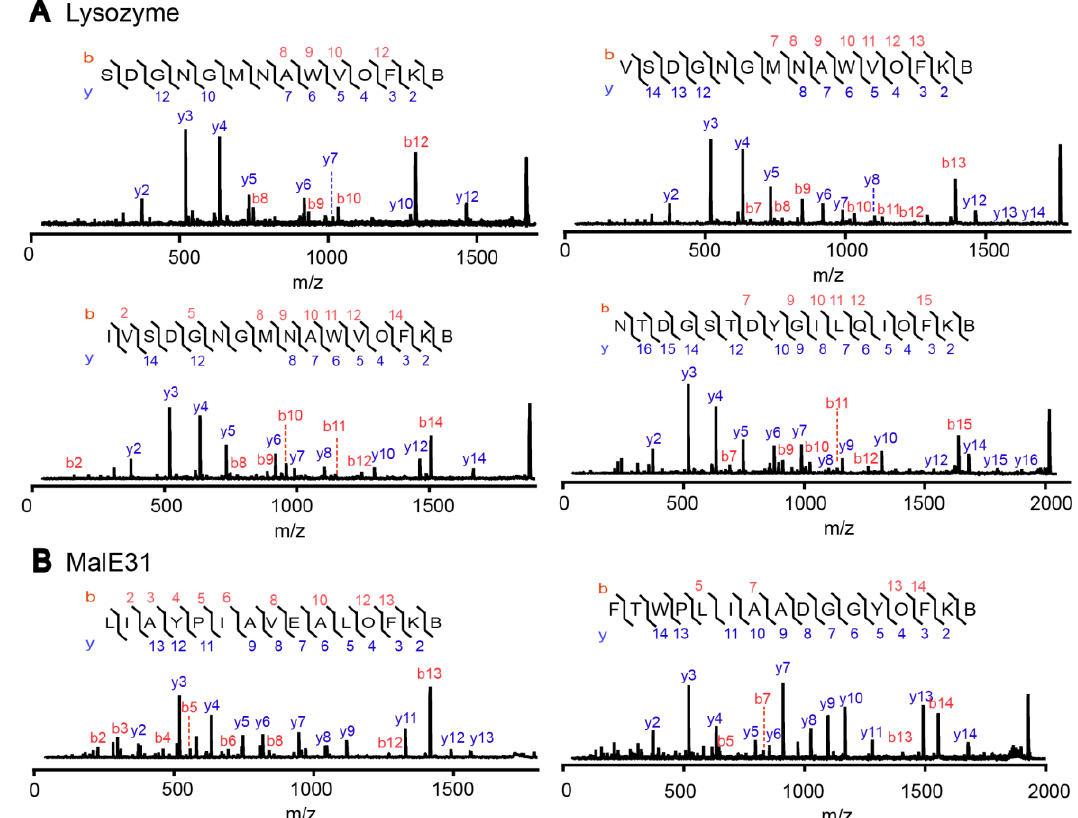
Figure 7. The probe addition products of the model protein substrates lysozyme ( A ) and MalE31 ( B ) were identified by MALDI-TOF-MS/MS. Misfolded lysozyme and MalE31 (80 µ M each) were degraded by DegP (10 µ M) in the presence of the OFK(biotin) probe (10 mM). The reaction products were further cleaved by trypsin and subjected to MALDI-TOF-MS in which several peaks were further analyzed by